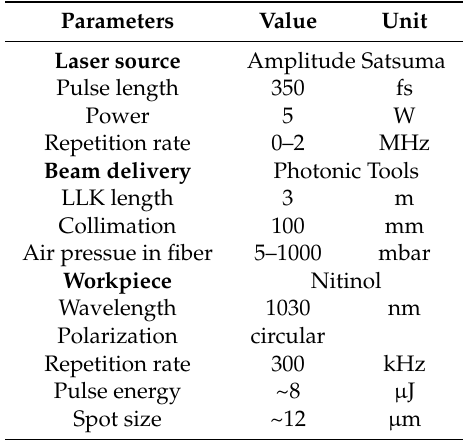
Table 1. Processing parameters of nitinol